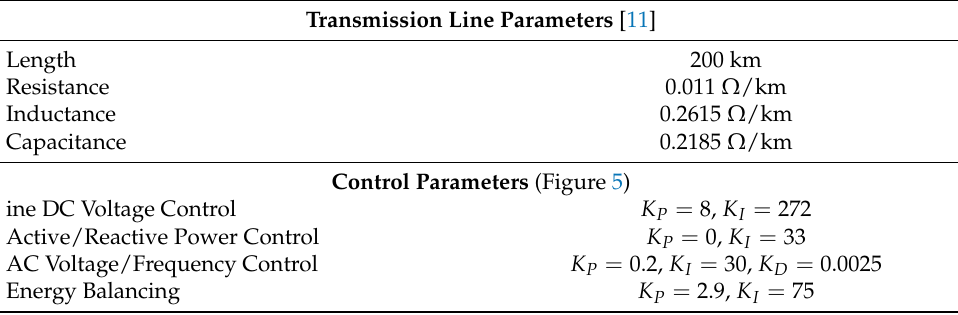
Figure 5. Control structure for hybrid VSC-HVDC system: ( a ) high-level converter station control common to both MMC and AAC, ( b ) MMC internal converter control, and ( c ) AAC internal converter control. Table 2. DC cable parameters and controller